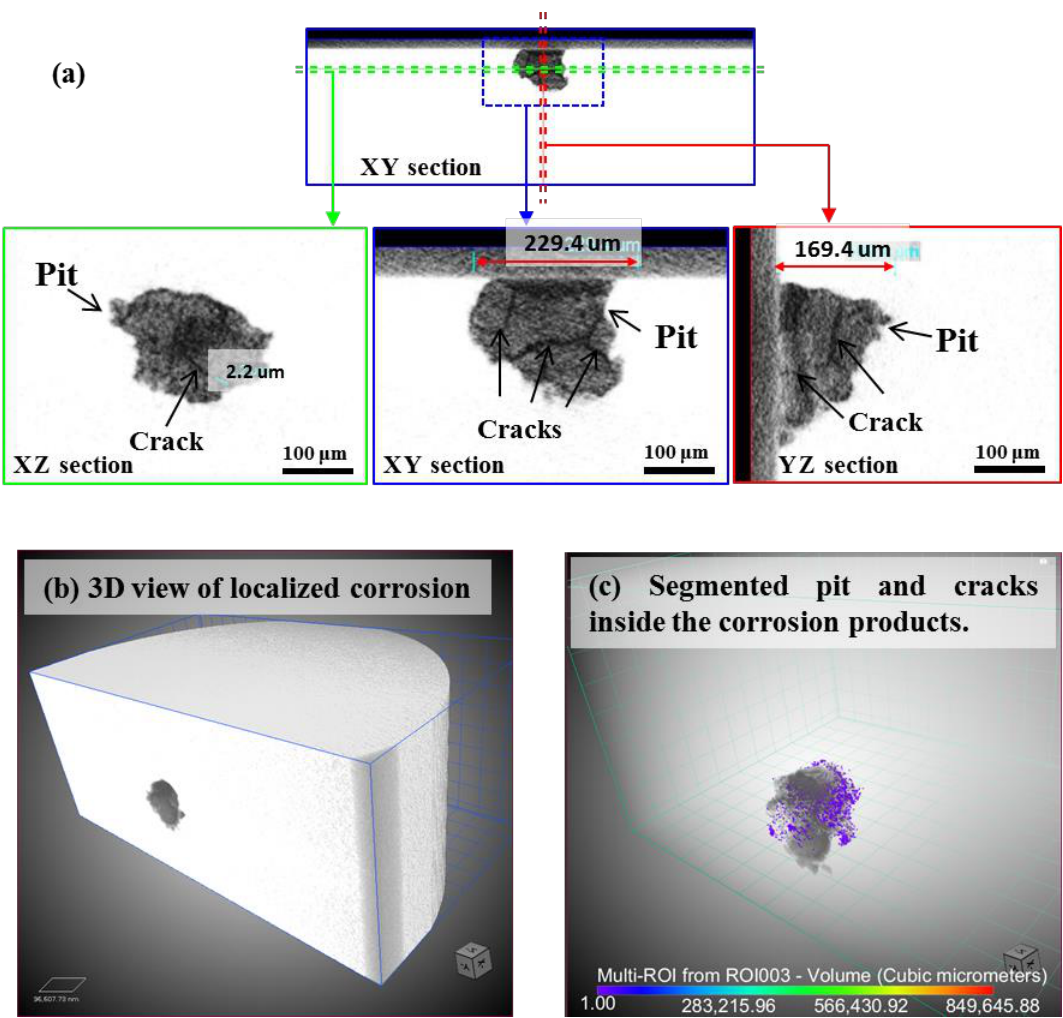
Figure 8. XCT data of localized corrosion of specimen A: ( a ) Virtual slices in different sections; ( b ) 3D tomogram; ( c ) Segmented pit and cracks inside the corrosion products with transparent volume of material. Here, the color is based on the volume. Online version in color.